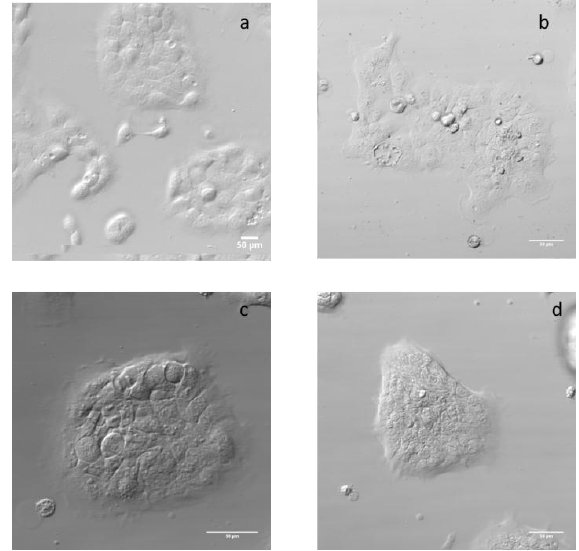
Figure 4. Images of HaCaT cell by phase contrast microscopy. Control cells without treatment ( a ), cells treated for 24 h with 25 µg/mL of ZnO ( b ), ZnO 50 nm ( c ) and ZnO 100 nm ( d ).